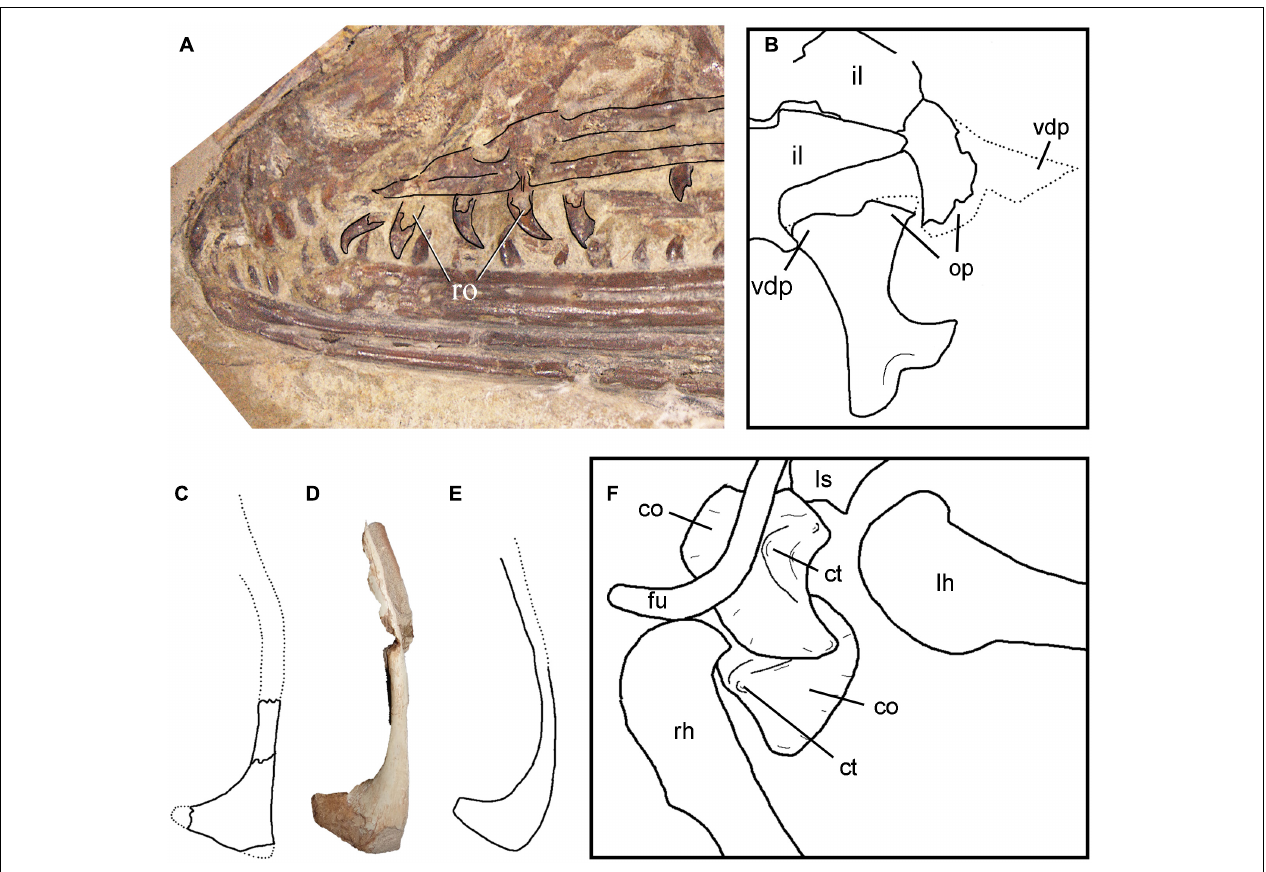
FIGURE 7 | Re-evaluation of Anchiornis -like paravians: (A) Serikornis sungei maxillary teeth indicating the inner root and external displacement (modified from Lefèvre et al., 2017); (B) re-interpretation of the right coracoid of Serikornis sungei indicating the position of the coracoid tubercle (modified from Lefèvre et al., 2017); (B–E) right pubes in lateral view of Ostromia crassipes (C) (modified from Foth and Rauhut, 2017); Buitreraptor gonzalezorum (D) (MPCA-PV-598); and Anchiornis huxleyi (E) (BMNHC PH 828) showing the posterior flexure of the pubic shaft, sub-triangular shape of the pubic boot and flat ventral margin of the pubic boot; (F) re-interpretation of ischium of Anchiornis huxleyi (modified from Lefèvre et al., 2017). Not to scale. co, coracoids; ct, coracoid tuber; cv, caudal vertebrae; f, femur; fu, furcula; il, ilium; lh, left humerus; lpr, lateral process of the coracoid; ls, left scapula; op, obturator process; rh, right humerus; ro, inner root of teeth; rs, right scapula sac, sacral vertebrae, vdp, ventrodistal